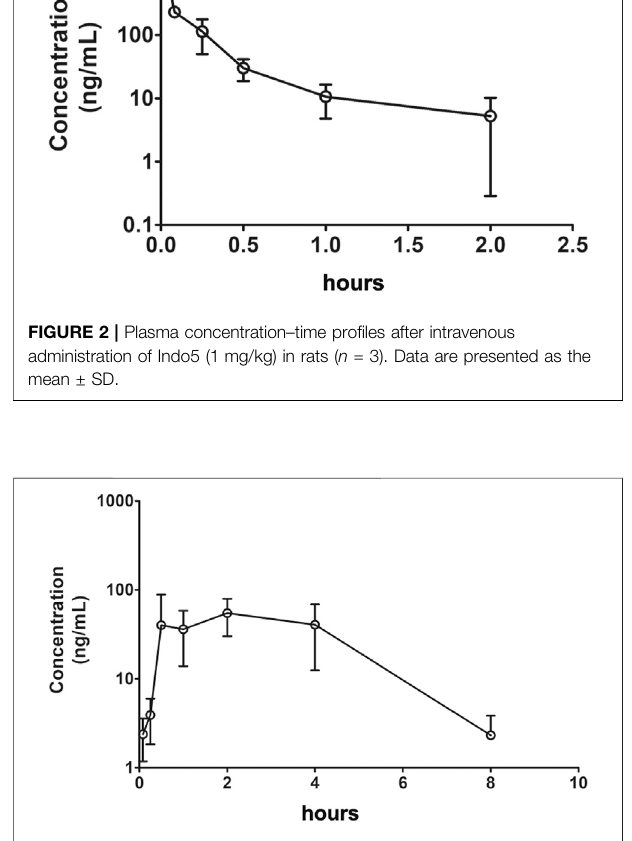
FIGURE 3 | Plasma concentration – time pro fi les after oral administration of Indo5 (100 mg/kg) in rats ( n (cid:2) 3). Data are presented as the mean ±